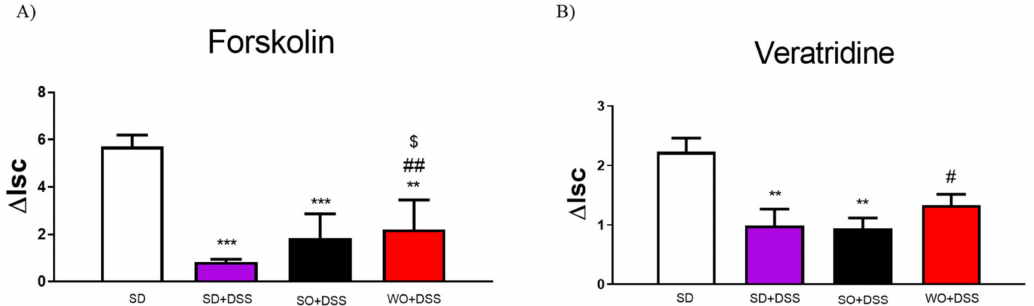
Figure 5. Changes in forskolin-stimulated ( A ) and veratridine-stimulated ( B ) short-circuit current ( ∆ Isc) in the colon of mice fed with diet enriched with sunflower oil (SO) and walnut oil (WO) and treated with DSS. Data represent mean ± SEM, n = 8. ** p < 0.01, *** p < 0.001, as compared to control; # p < 0.05, ## p < 0.01 as compared to DSS; $ p < 0.05, as compared to sunflower oil (SO +